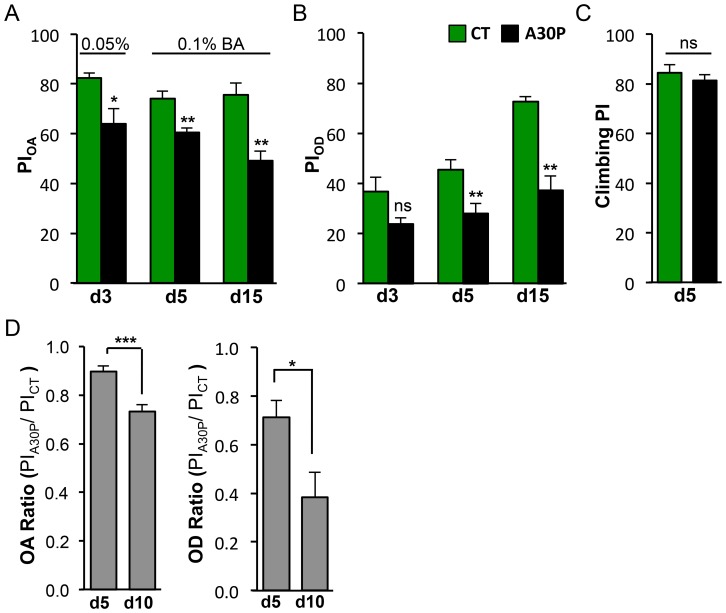
A30P flies show age-accelerated deficit in odor acuity and odor discrimination.(A) A30P flies showed decreased odor acuity (d3: t(6) = 2.916, *P = 0.0268; d5: t(10) = 3.982, **P = 0.0026; d15: t(5) = 4.046, **P = 0.0099). Odors used are 0.05% BA vs. air on day3 and 0.1% BA versus air on day5 and day 10. (B) Aged A30P flies showed decreased performance in odor discrimination (d3: t(8) = 2.094, *P = 0.0695; d5: t(14) = 3.058, **P = 0.0085; d15: t(6) = 5.915, **P = 0.0010). Odor options were 1.5% BA made in 15% MCH background and 15% MCH. (C) A30P flies showed normal climbing on day 5 (t(14) = 0.7625, P = 0.480). (A–C) Olfactory deficits preceded motor deficit. (D) Aging exacerbated both OA and OD deficits in A30P flies. The PIs for OA and OD were presented as ratios of PIA30P over PICT. Odors used in OA assays were 0.1% BA and air. Odors used in OD assays were the same as in Figure 2B. OA ratio: t(14) = 4.563, ***P = 0.0004; OD ratio: t(7) = 2.680, *P = 0.0316, Student t-test.